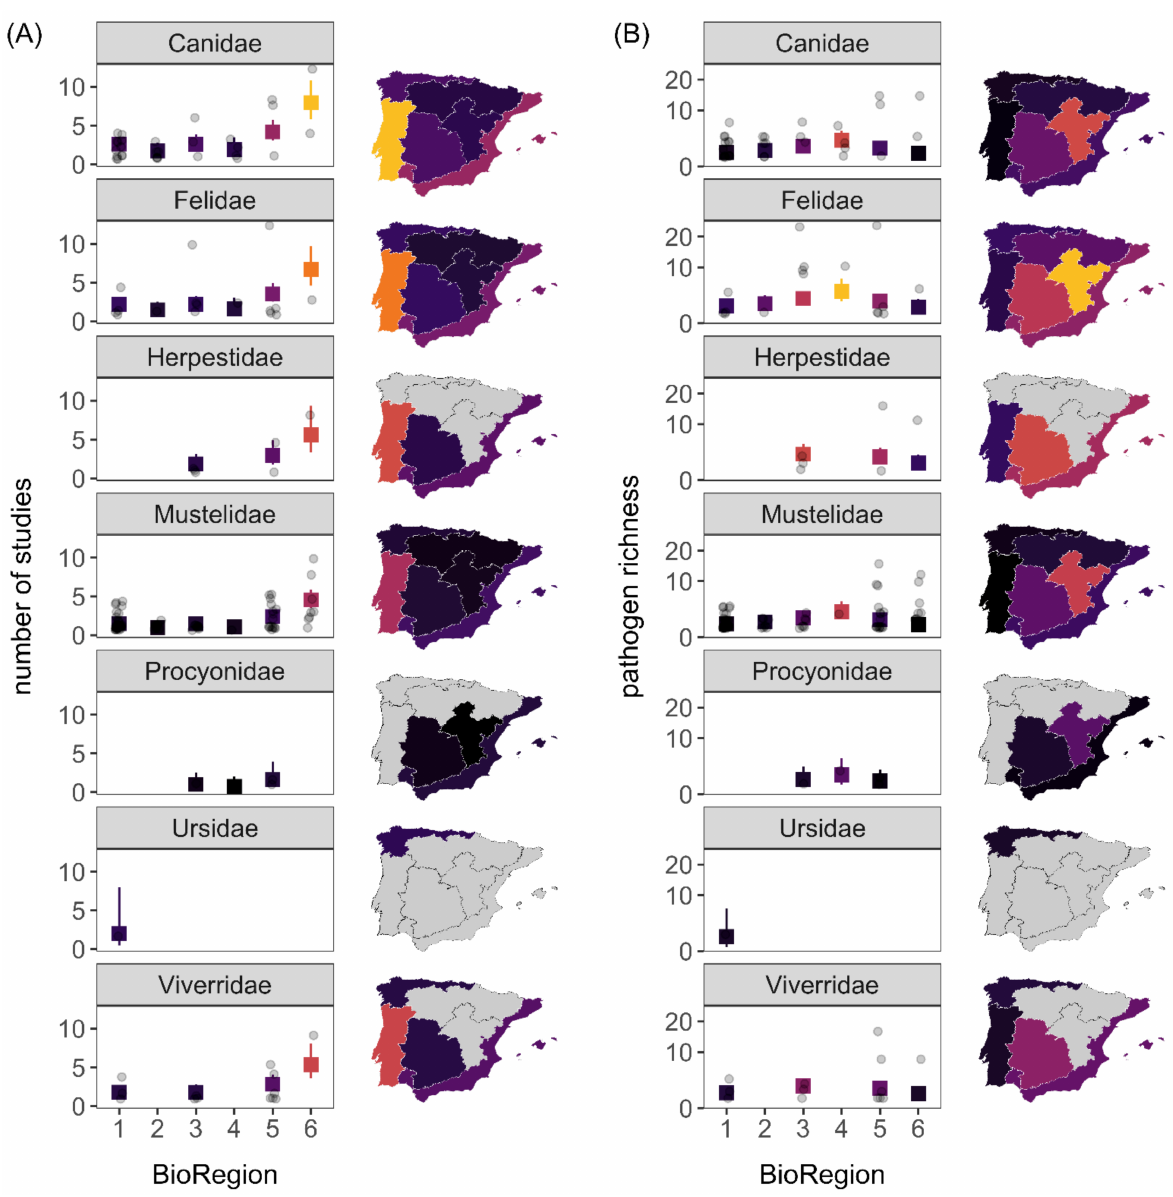
Figure 3. Sampling effort (i.e., number of studies; A ) and pathogen richness ( B ) as a function of carnivore family and bioregion. Predicted means and 95% confidence intervals from GLMs are shown with raw data. Choropleth maps display the predicted mean responses for bioregion averaged across carnivore family. Modeled results for pathogen richness display predictions after adjusting for mean sampling effort, and the vertical axis uses a modulus transformation to accommodate the skewed